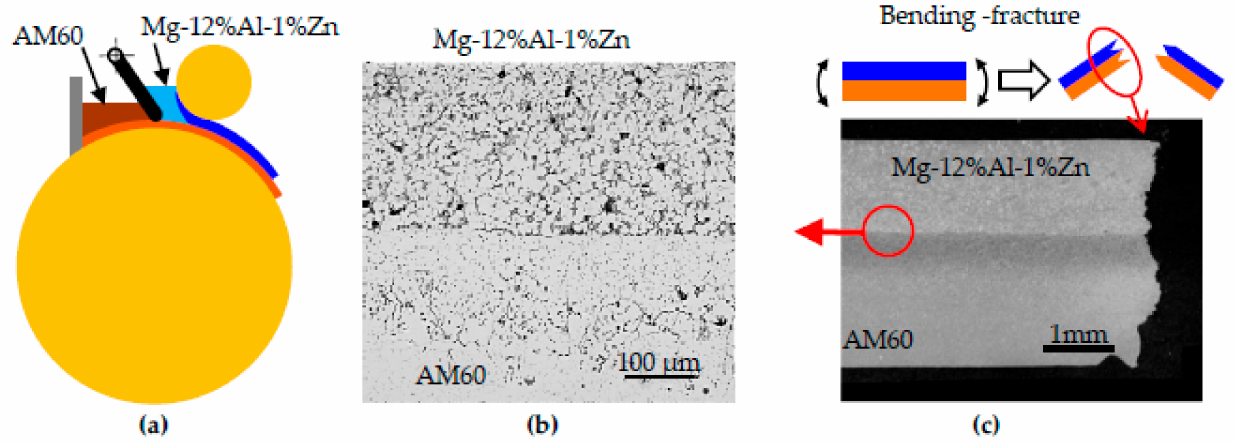
Figure 24. Cross-section of clad strip consisting of AM60 base strip and Mg-12%Al-1%Zn overlay strip cast using an unequal-diameter twin roll caster equipped with a scraper, and result of the bending-fracture test. ( a ) Unequal-diameter twin roll caster equipped with a scraper used to cast the clad strip. ( b ) Interface between the AM60 base strip and the Mg-12%Al-1%Zn overlay strip. ( c ) Cross-section of fracture area after the bending-fracture test.